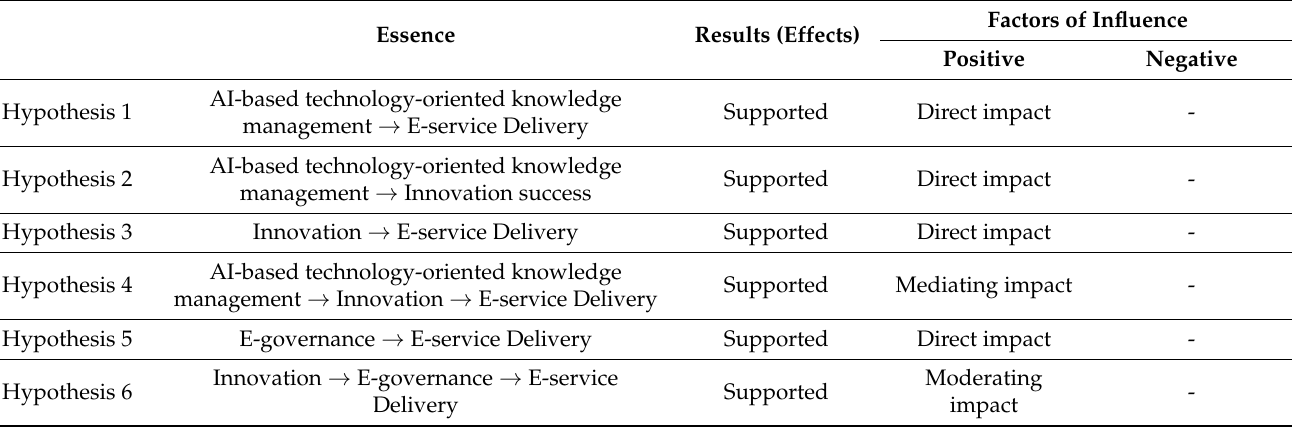
Table 6. Generalization of the hypotheses of artificial intelligence-based technological oriented knowledge management, innovation, and e-service delivery in smart